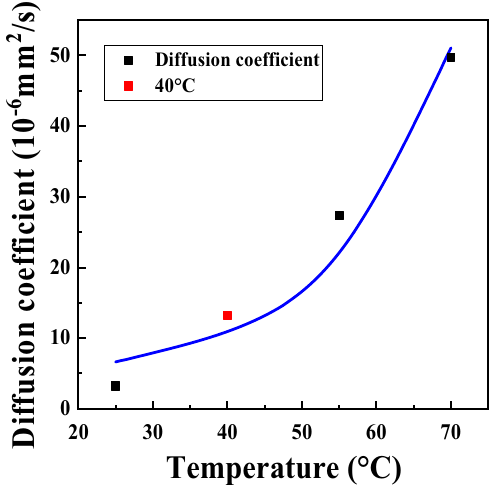
Figure 5: Di ff usion coe ffi cient versus to temperature curve in hydrothermal aging process.